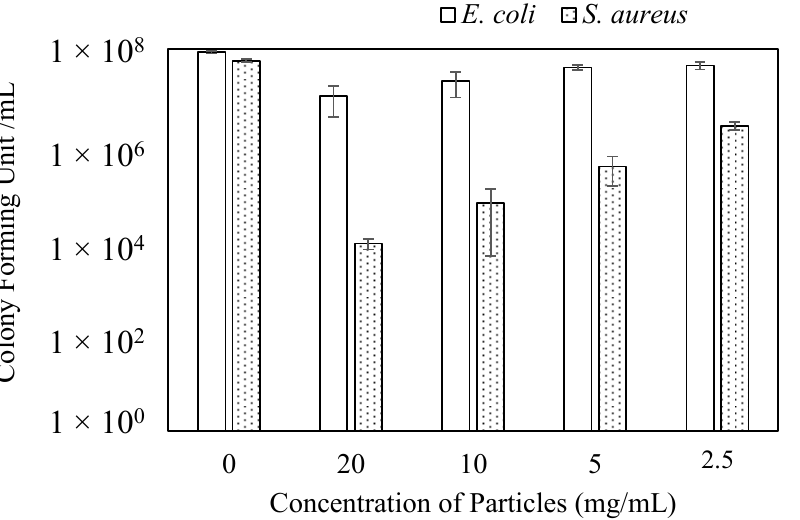
Figure 7. Inhibition of colony forming unit/mL depending on concentration (mg/mL) of p (TA)/200X particles.